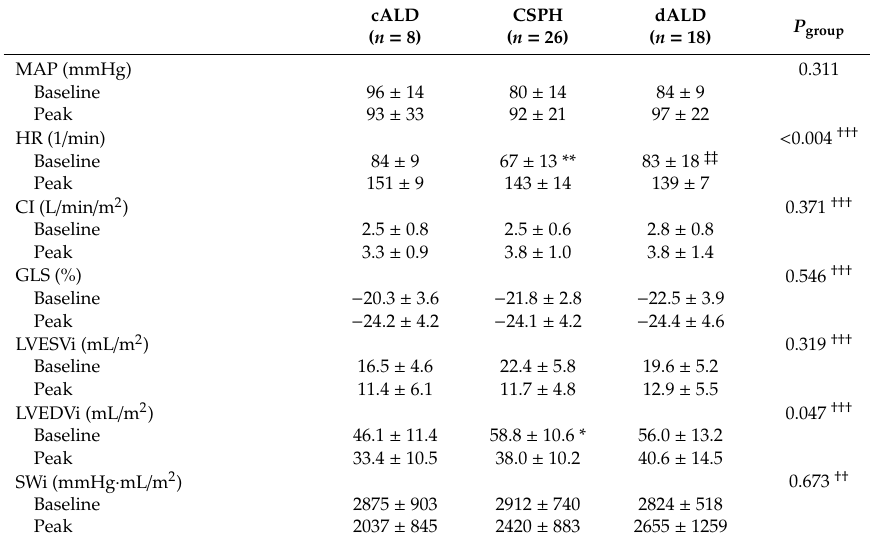
Table 3. Stress echo parameters (mean +/ − SD).